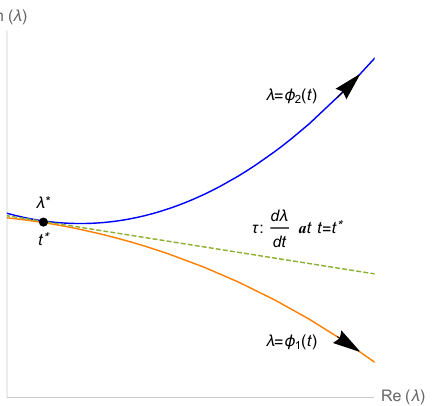
Figure 4. Parametric curves λ ( t ) osculating each other at t = t ∗